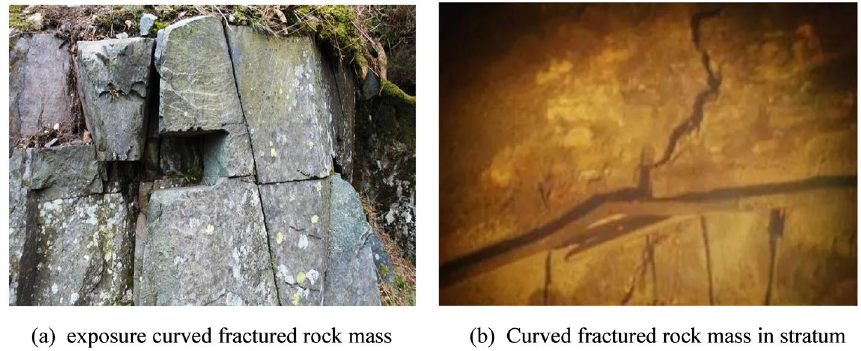
Figure 1. Different rock fracture structures in geological